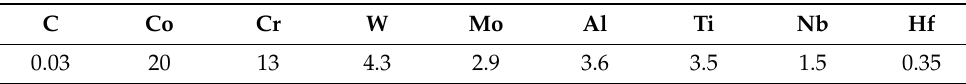
Table 2. Chemical composition of